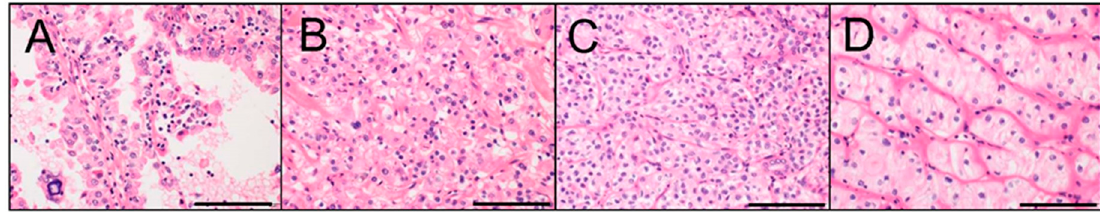
Figure 1. Morphology of MiT family tRCC (Hematoxylin and Eosin staining; scale bar, 100 µm). ( A ) Xp11 tRCC, ( B ) t(6;11) RCC (Case 1), ( C ) t(6;11) RCC (Case 2), and ( D ) t(6;11) RCC (Case 3).